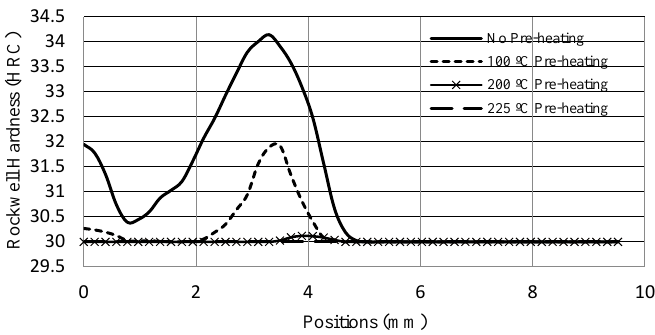
Figure 14. Distribution of hardness at the mid transverse direction of the welding line through the HAZ for different states of preheating.